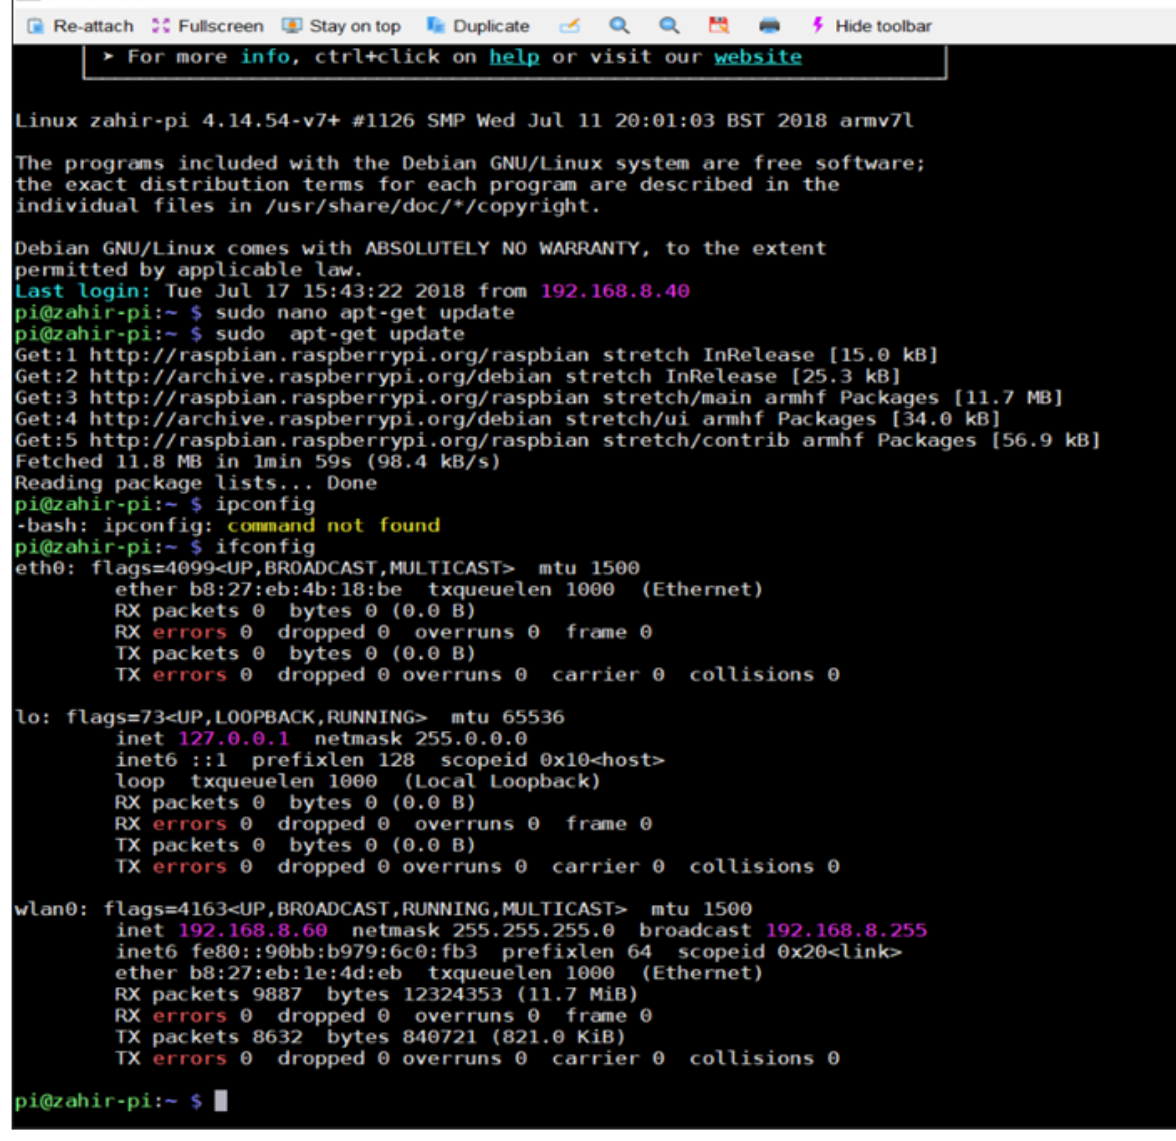
Figure 3. The screenshot of the Terminal